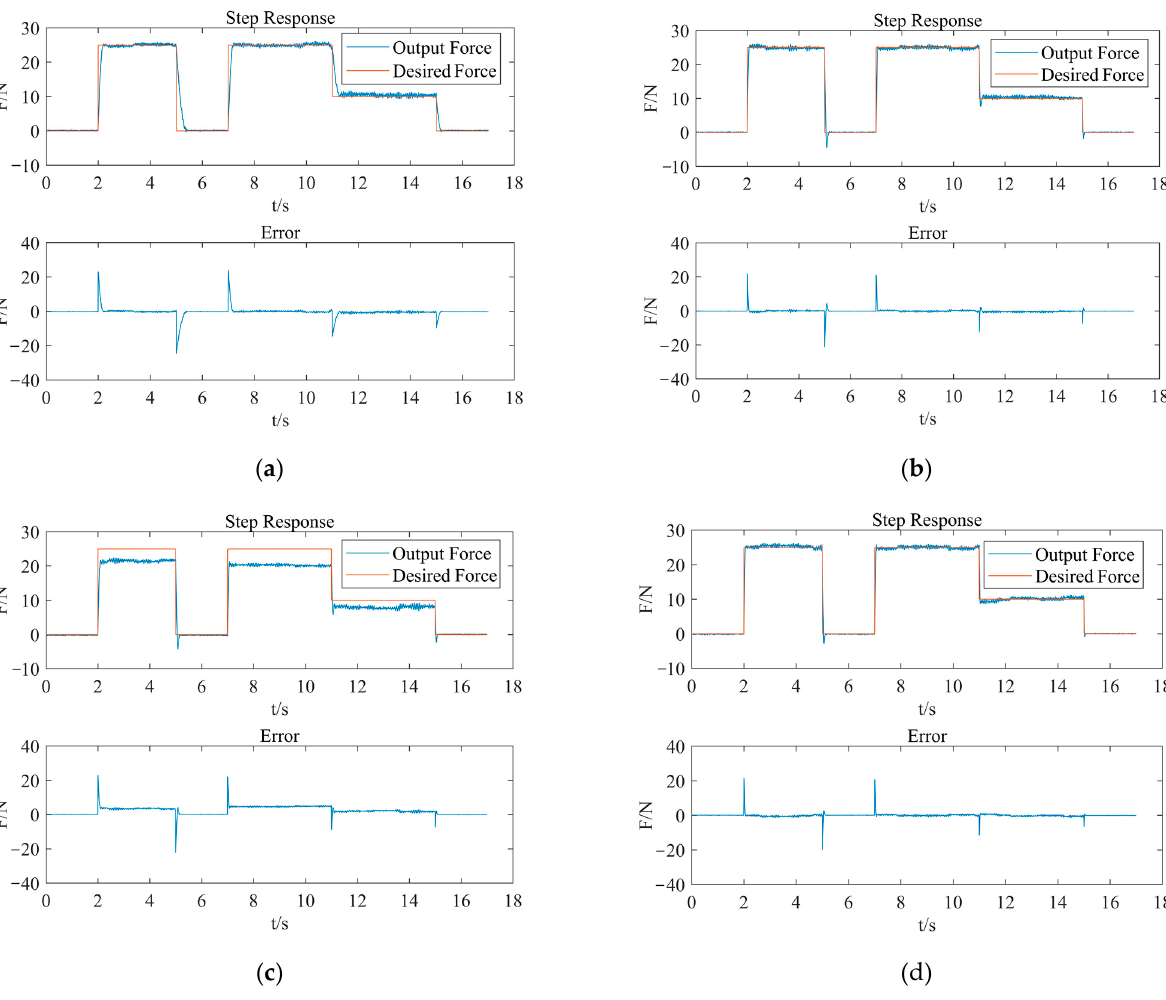
Figure 10. Step response analysis of contact force. ( a ) Open-loop control; ( b ) PID control; ( c ) Fuzzy control; ( d ) Fuzzy-RBF-PID control.